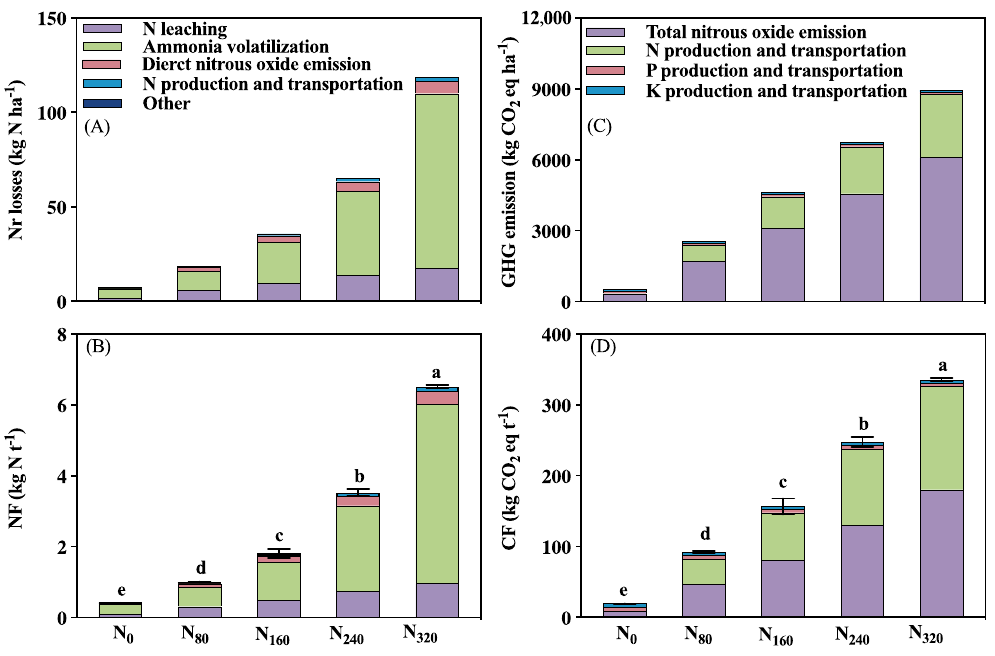
Figure 7. Average Nr losses ( A ), NF ( B ), GHG emissions ( C ), and CF ( D ) across 2019 − 2020 growing seasons in forage sorghum life cycle as affected by N treatments. Different lowercase letters indicate significant differences at p < 0.05 among the different N treatments.